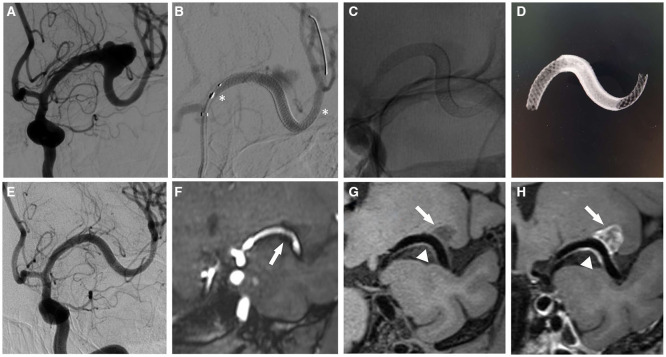
A 44 year-old woman with a middle cerebral artery aneurysm. (A) DSA shows the large irregular wide-necked aneurysm of the left middle cerebral artery M1 segment. (B) Cerebral angiography demonstrates the dual overlapping Pipeline Flex embolization devices (asterisk). (C,D) no subtraction angiography (C) and reconstruction of Vaso CT (D) performed immediately after the PED treatment shows the morphology and position of the stents. (E) the aneurysm completely occluded at 6 month follow-up. (F) the 3D-TOF MRA sequence also reveals a total occlusion of the aneurysm, however there was artifactual luminal narrowing of the stented parent artery (arrow). (G) the 3D T1-SPACE sequence demonstrates that excellent-quality diagnostic information of in-stent lumen without metal artifacts (arrowhead). (H) Enhanced scanning shows mixed signal intensity in the aneurysm sac (arrow), which is considered to the thrombus composition.